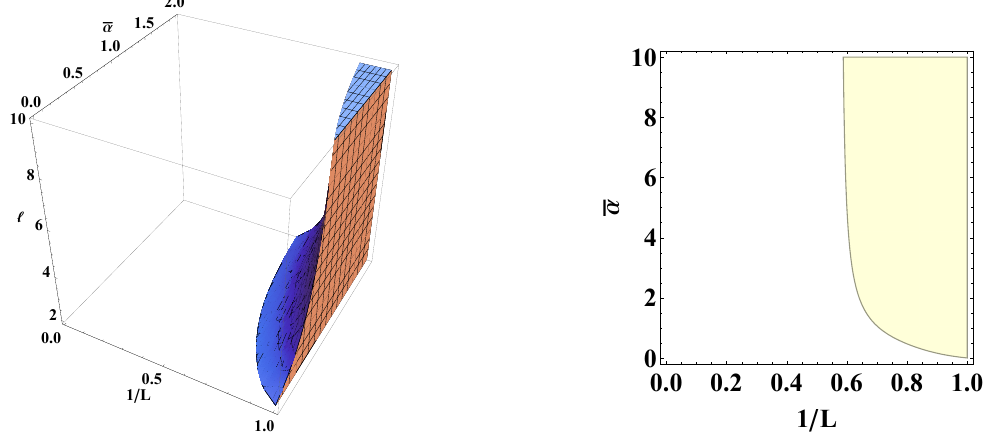
p 2 (cid:25) 0 : 71,